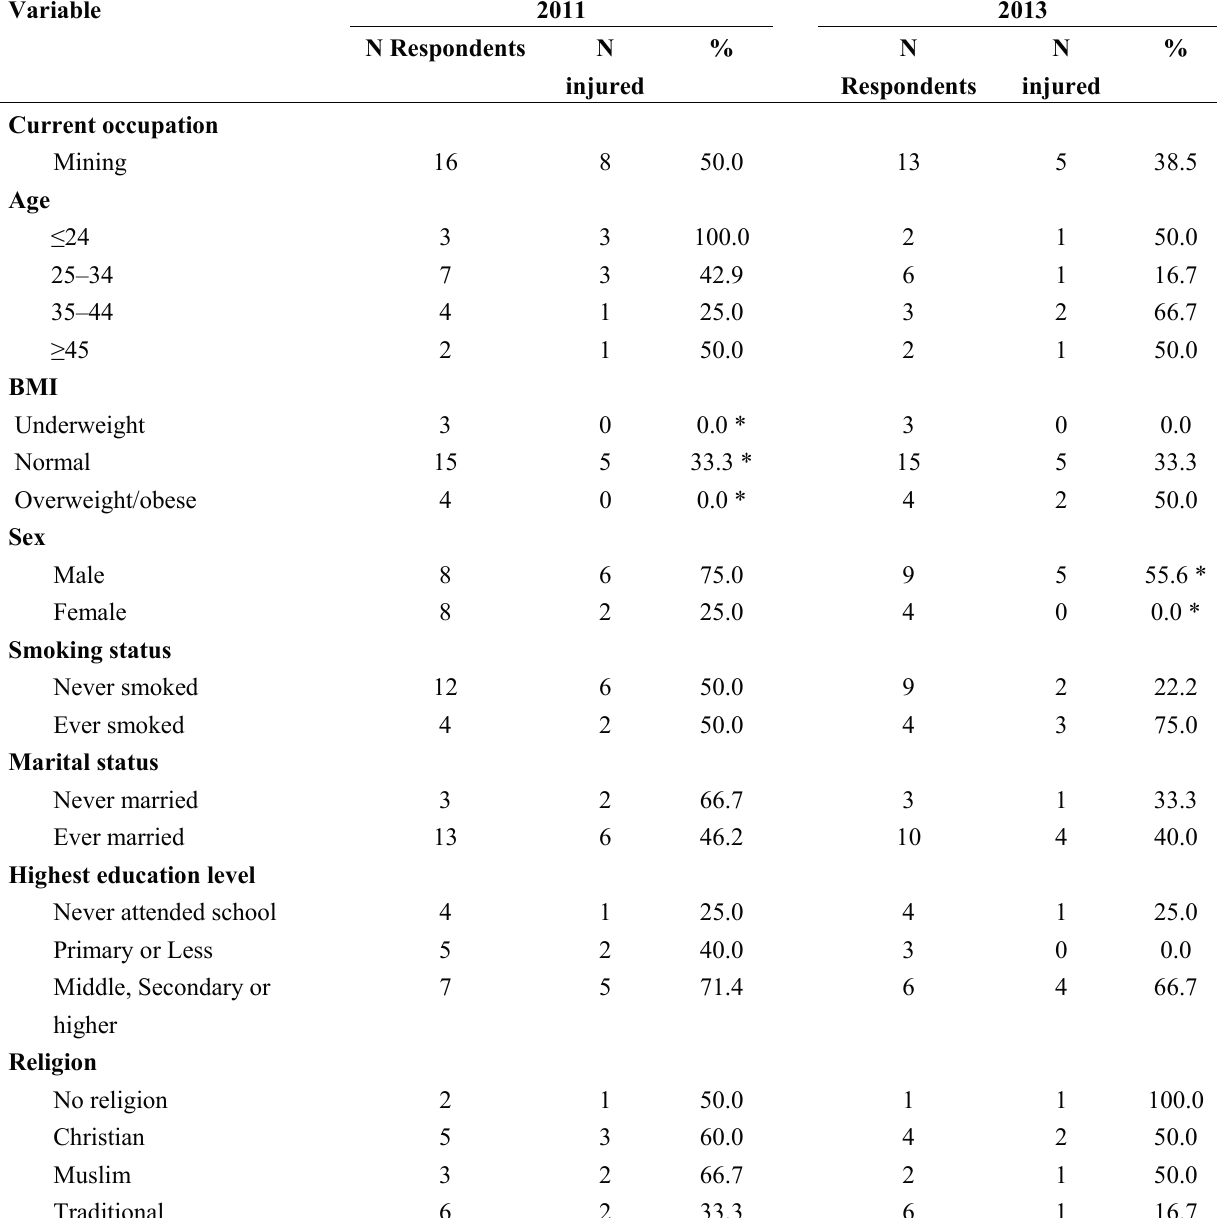
Table 2. Injury experience for 2013 subsample of ever-miners in 2011 and 2013, N = 17.